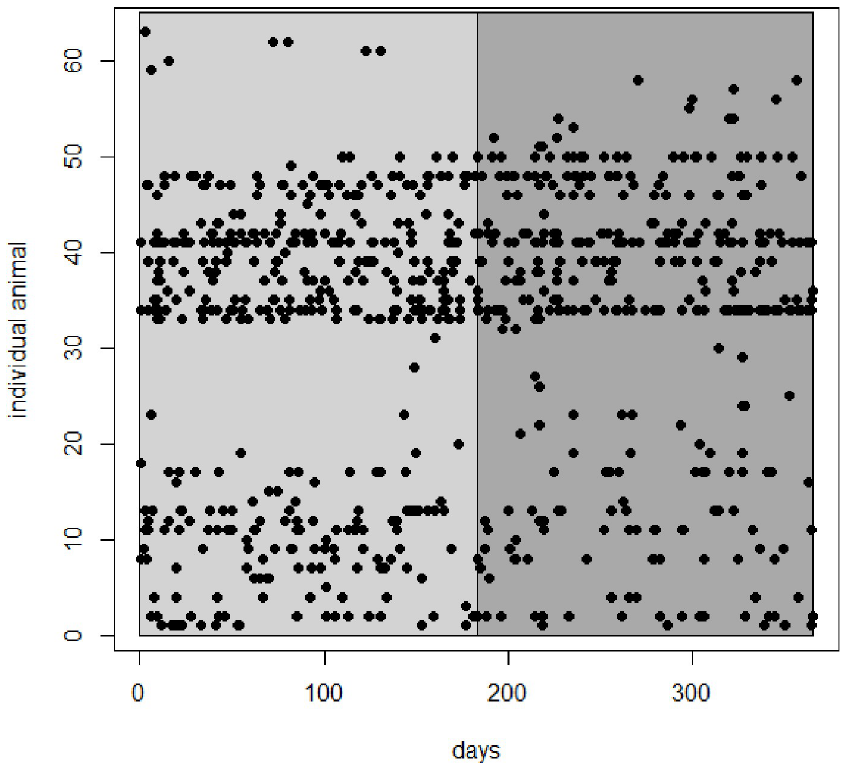
Fig 2. Individual leopard detections over the summer (light grey) and winter (dark grey) of 2017–2018, in the Cederberg, Western Cape.